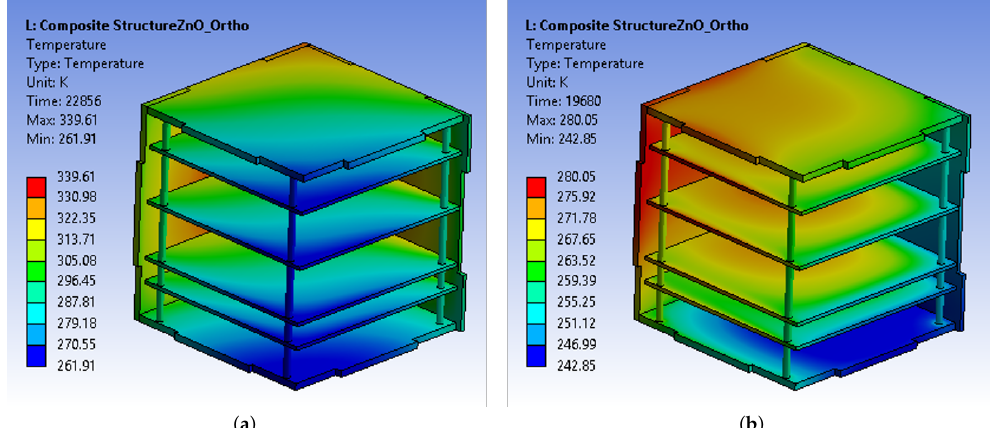
Figure 7. Temperature field at the surface of the CubeSat panels and electronic boards, ( a ) t = 19,620 s, ( b ) t = 22,856 s ( β = 57 ◦